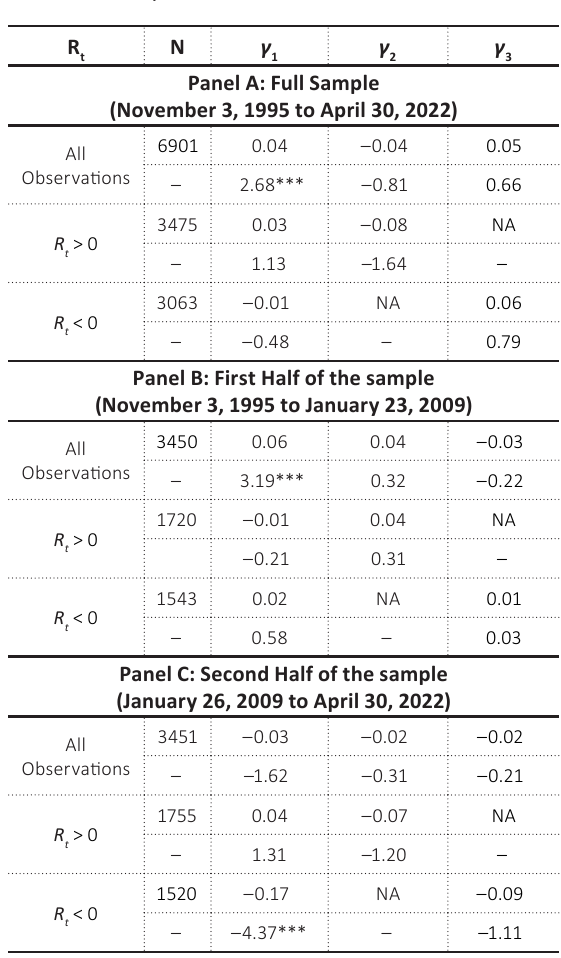
Table 4. Regression results for the full sample and